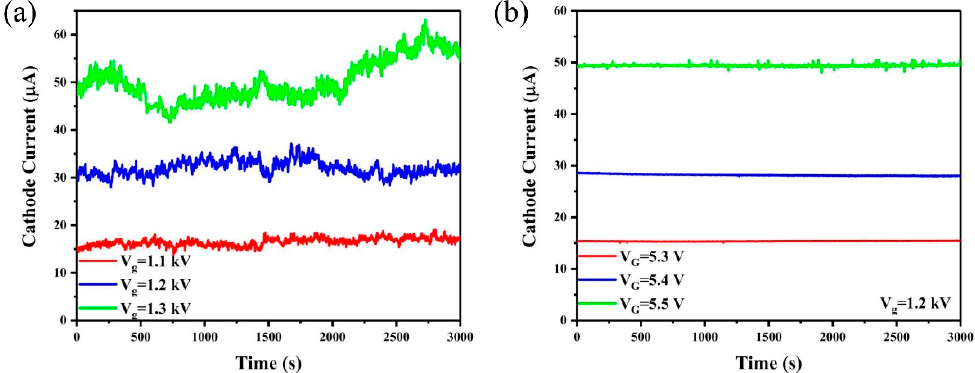
Figure 5. The cathode current stability of CNT cold cathode electron source ( a ) without and ( b ) with IGBT modulation.